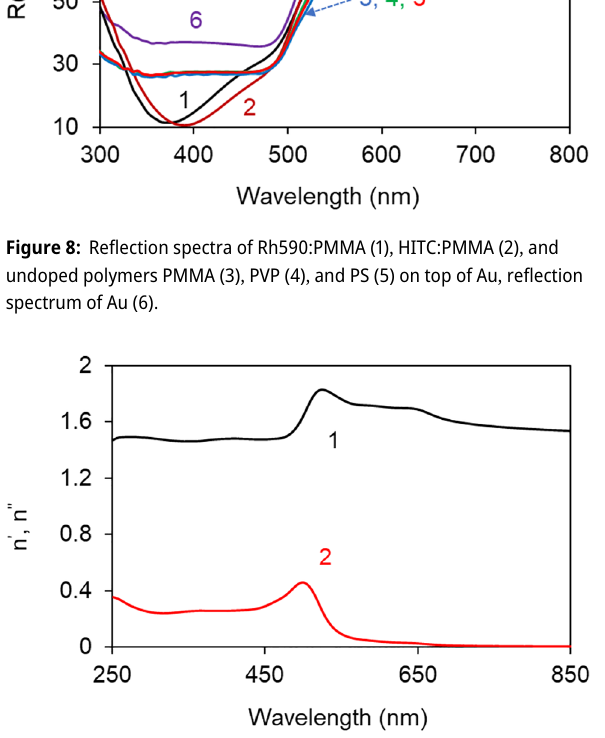
Figure 9: Calculated spectra of real (1) and imaginary (2) parts of refractive indexes of SPPs propagating at the interface between Au and undoped PMMA